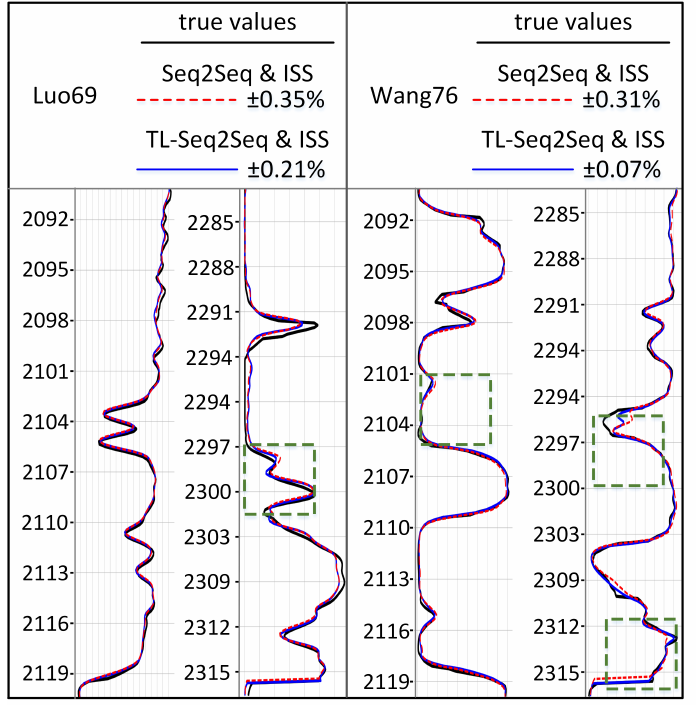
Figure 15. Comparison experimental results using Seq2Seq and TL-Seq2Seq.